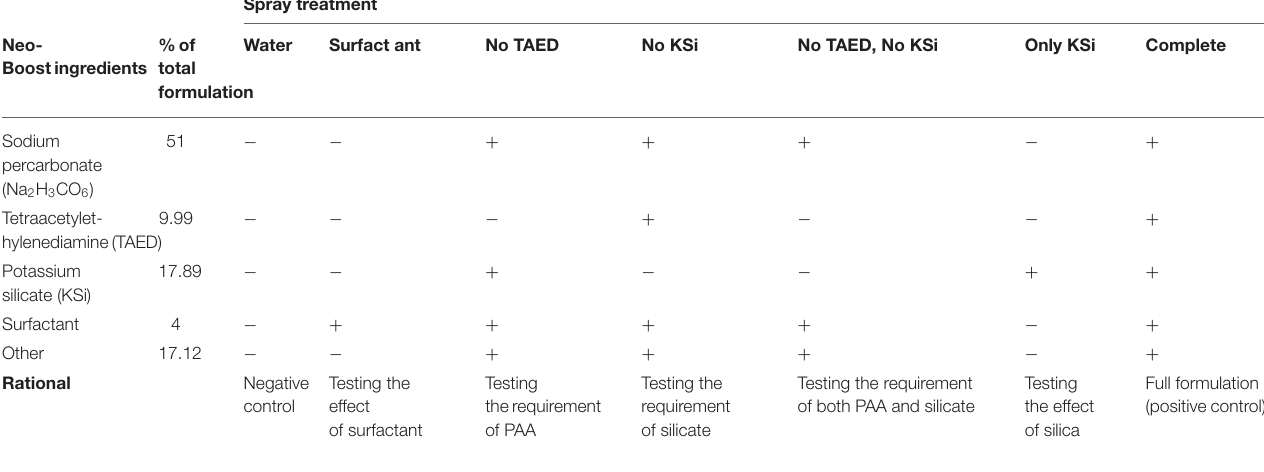
TABLE 2 | Spray treatments containing different combinations of ingredients in the Neo-Boost